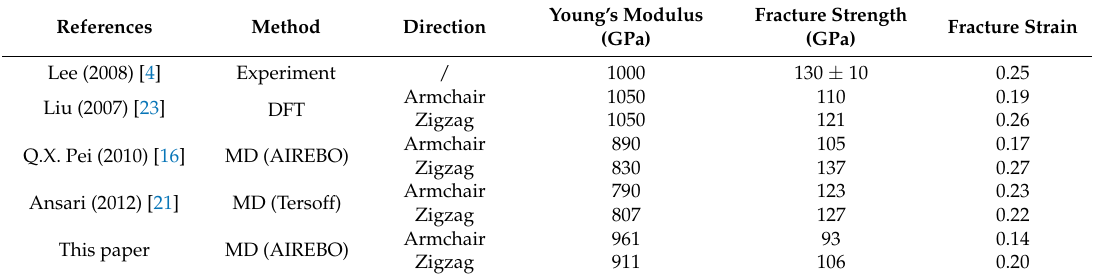
Table 1. The calculated results and relevant values obtained by previous simulations or